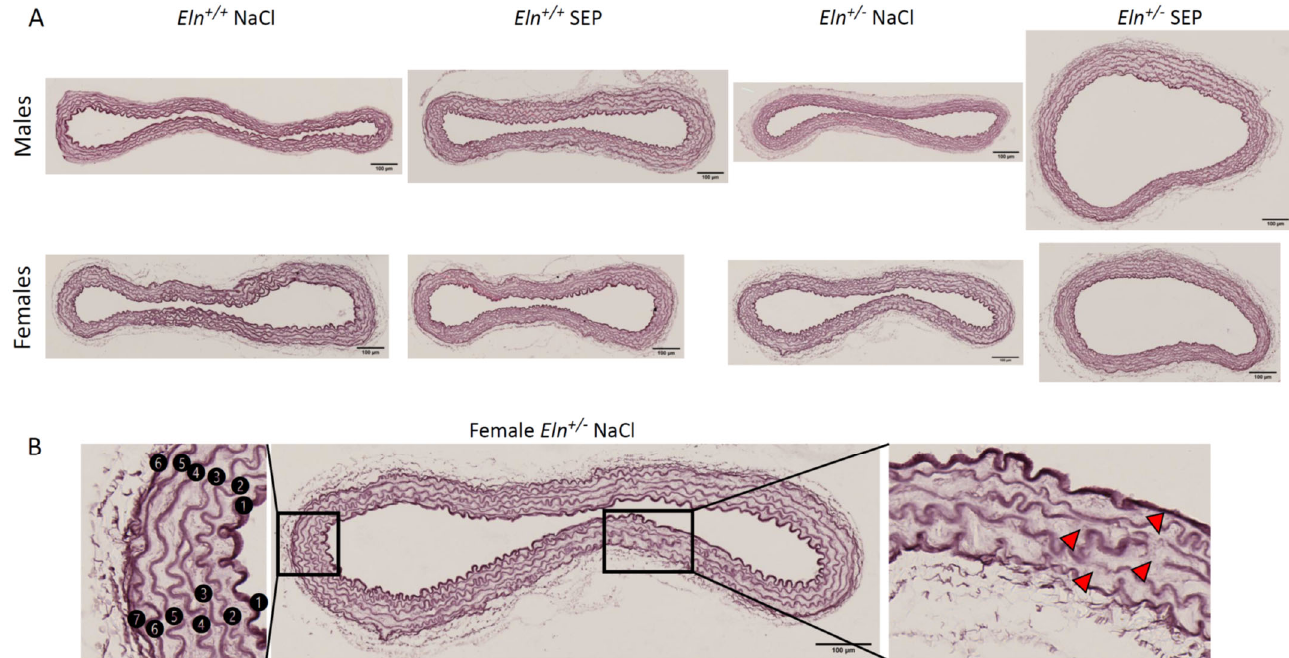
Figure 5. Elastic lamella detection by orcein staining in cross-sections of the distal part of the aortic arch of Eln +/+ or Eln +/- male or female mice injected with SEP or 0.9% NaCl (control). ( A ) Representative images for each group. ( B ) Descriptive example, for an Eln +/- female mouse injected with 0.9% NaCl (control), of the process used for the quantification of elastic lamella abnormalities: (i) on the left, the numbering of each elastic lamella from the luminal side (#1: internal elastic lamina) to the external side of the media (#6 or #7, depending on the vessel), and (ii) on the right, the identification of elastic lamella disruptions (red arrowheads). Scale bars = 100 μ m.